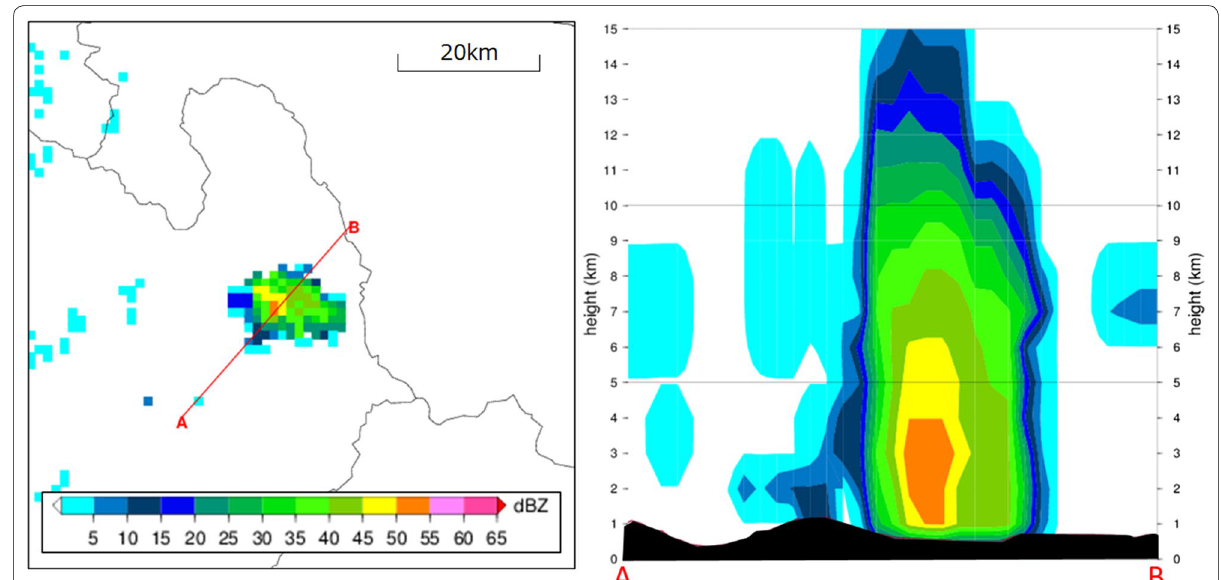
Fig. 3 3 km CAPPI of reflectivity (2:00 JST, October 8, 2016) (left) and vertical cross section (right) along line A–B. The echo height may be